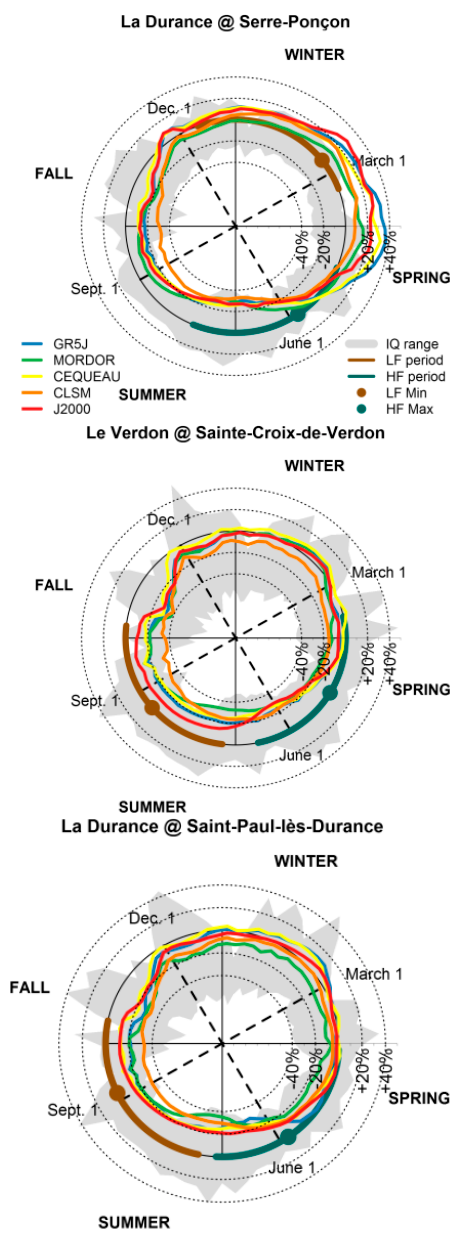
Figure 3. Mean relative changes of five ‐ day moving average discharges for the five hydrological models GR5J, MORDOR, CEQUEAU, CLSM and J2000 with respect to the 1980–2009 period. Thick lines represent the present ‐ day, three ‐ month period of low flows and high flows. The dots indicate the occurrence of the minimum and the maximum of the mean of the five ‐ day moving average discharges under current conditions.